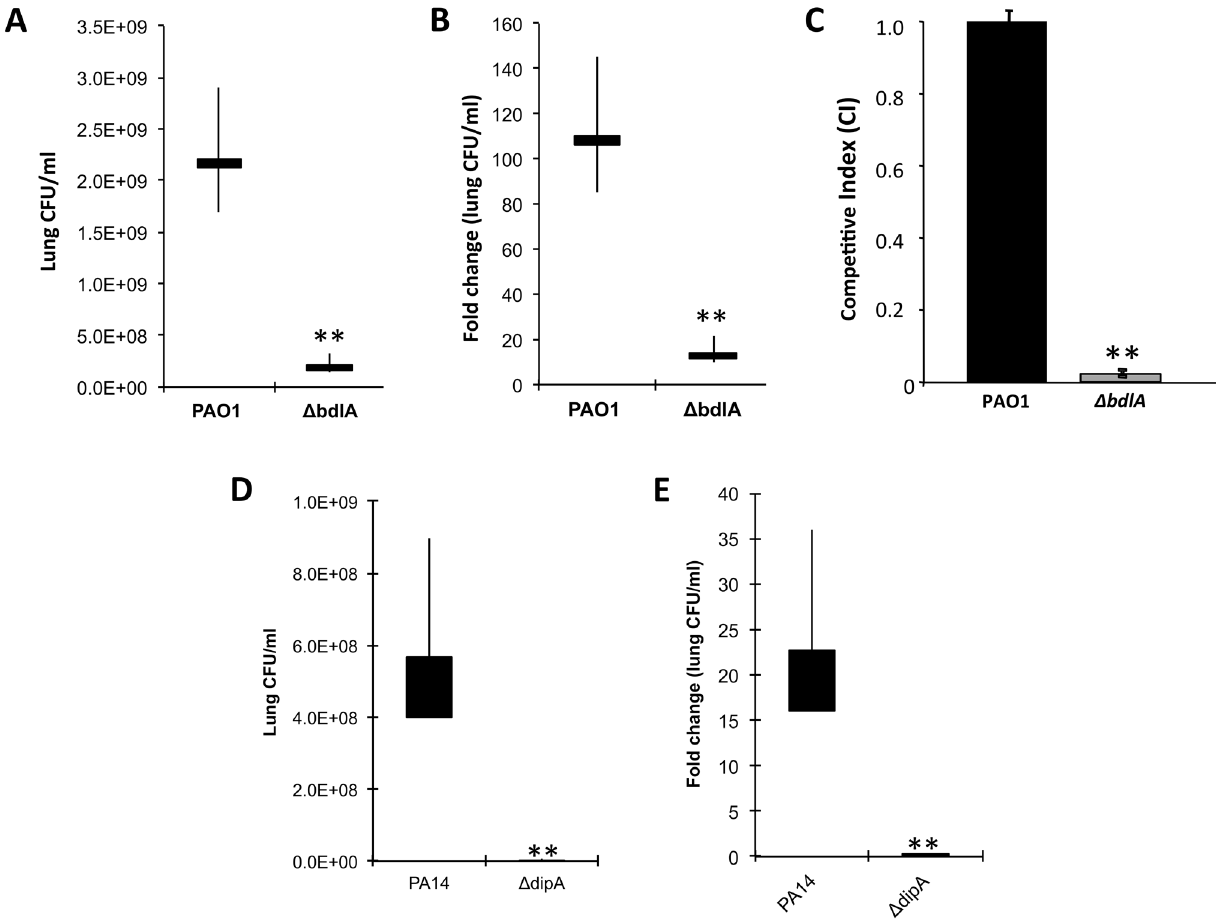
Figure 6. The non-dispersing P.aeruginosa D bdlA and D dipA mutant strains are less virulent and competitive compared to P. aeruginosa wild type as determined using an acute murine pneumonia infection model. CD1 mice were inoculated (intranasal) with 2 6 10 7 CFU of Pseudomonas strains; lungs were harvested 24 h post-inoculation and CFU was determined. Values presented are average, min, max, mean. (A) Bacterial burden in the lung and (B) fold change in lung CFU/ml 24 hr post-infection compared to initial inoculum by P. aeruginosa PAO1 and the isogenic D bdlA mutant. Bars indicate average and median lung CFU/ml while vertical lines indicate the highest and lowest lung CFU/ml observed. (C) Competitive index was determined using mixed infection. bdlA is less competitive in an acute murine pneumonia infection model when co-inoculated with P. aeruginosa PAO1. Mice were inoculated intranasally with 1 6 10 7 cells (1:1 ratio) of wild type PA01 and isogenic D bdlA mutant. Error bars indicate standard deviation. (D) Bacterial burden in the lung and (E) fold change in lung CFU/ml 24 hr post-infection compared to initial inoculum by P. aeruginosa PA14 and the isogenic D dipA mutant. Bars indicate average and median lung CFU/ml while vertical lines indicate the highest and lowest lung CFU/ml observed. A total of 5 mice were used in per study. The values were tested by means of a Fisher test. **, significantly different from wild type (PAO1 or PA14), P-value , 0.001.